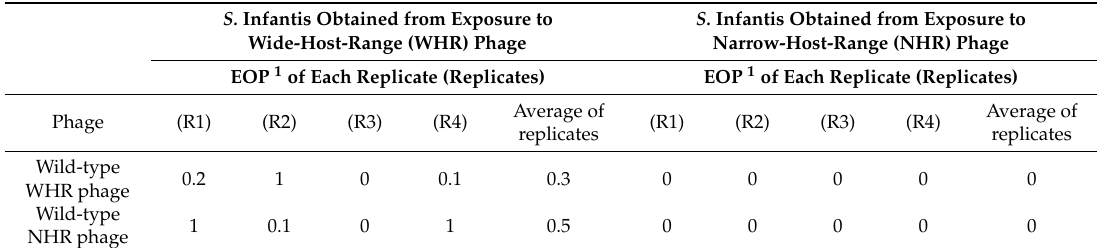
Table 4. Phenotypic assay of e ffi ciency of plating on S. Infantis obtained at 12 h of exposure to wide- and narrow-host-range phages in selective challenge